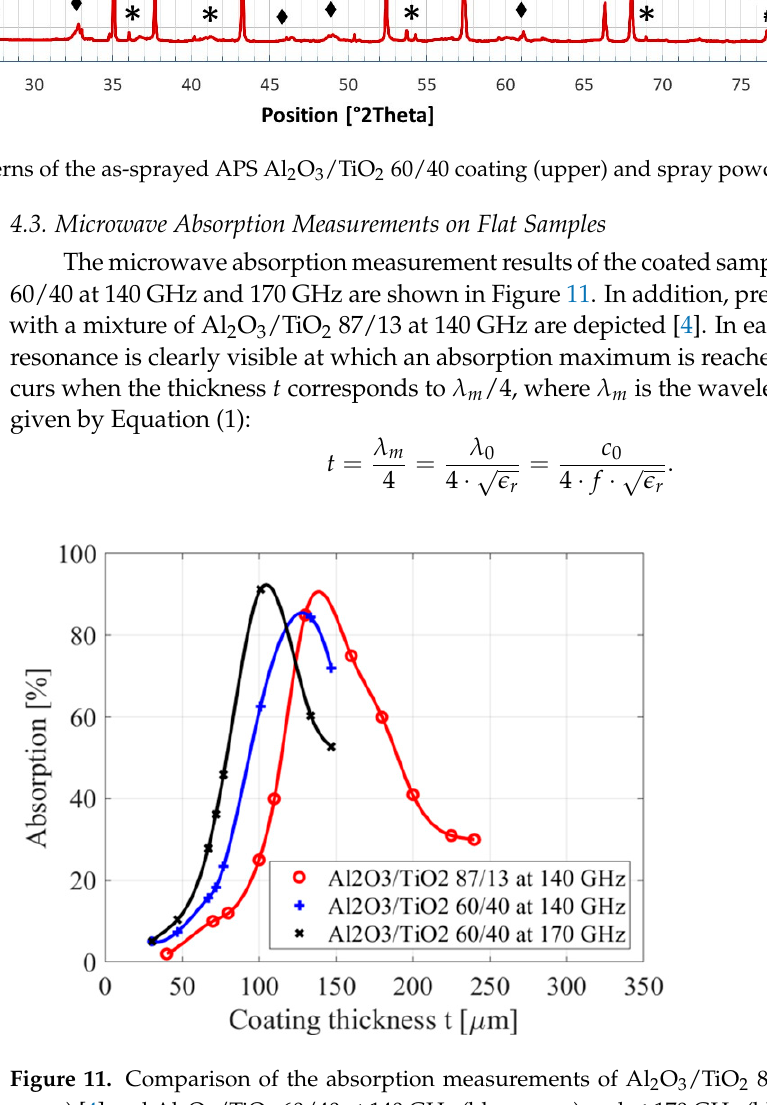
Figure 10. XRD patterns of the as-sprayed APS Al 2 O 3 /TiO 2 60/40 coating (upper) and spray powder (lower).